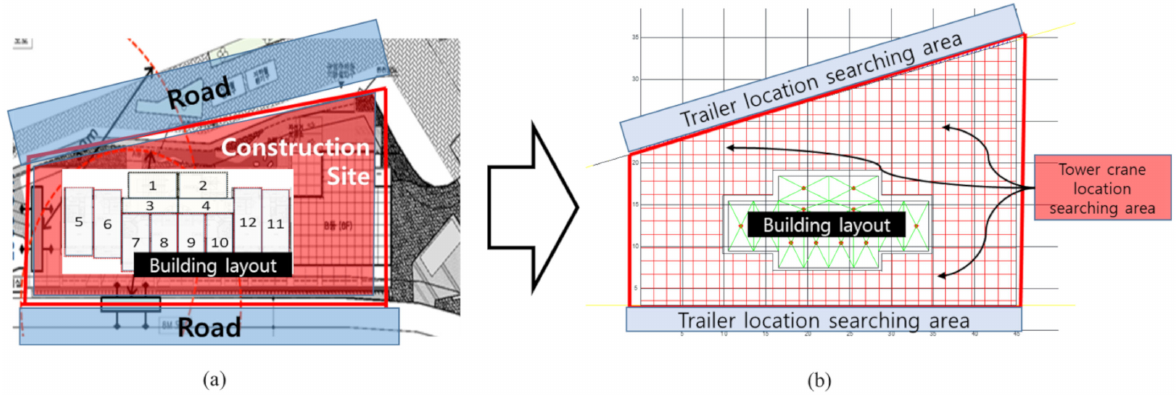
Figure 5. Set a tower crane and trailer location searching area based on the initial construction plan (legend: ( a ) is the road shape and building layout area of the initial construction plan, ( b ) is the search area for optimization). Table 2. Tower crane types and